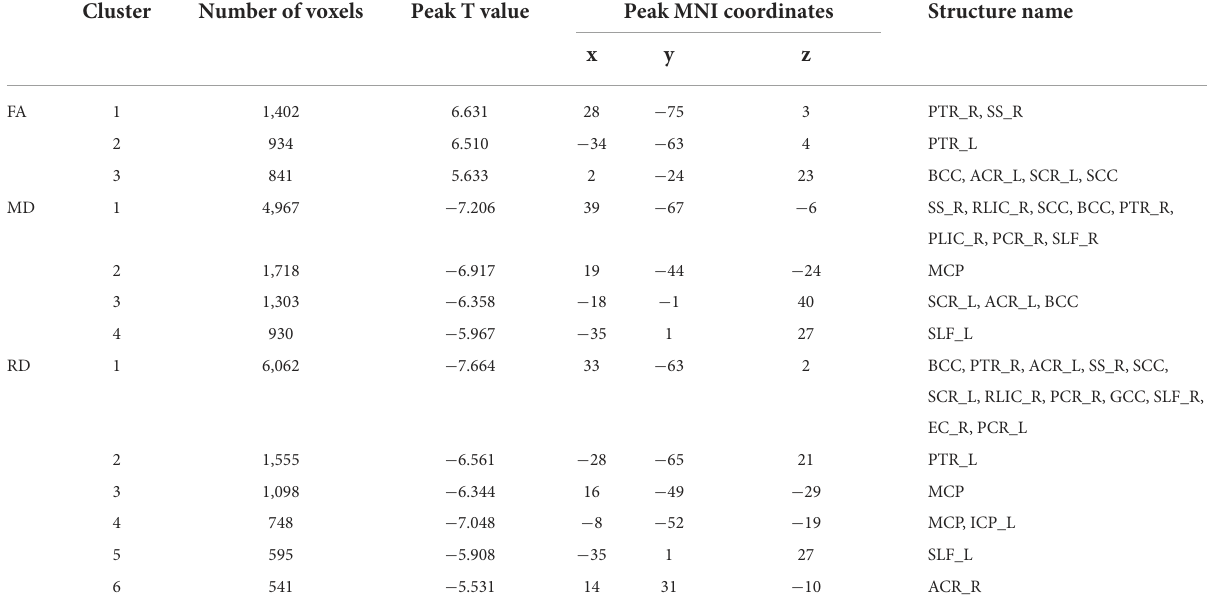
TABLE 4 Regions with significant differences in abnormal white matter bundles caused by different DTI parameters in the NDD-CKD and NC groups (only clusters larger than 500 voxels are shown). Cluster Number of voxels Peak T value Peak MNI coordinates Structure